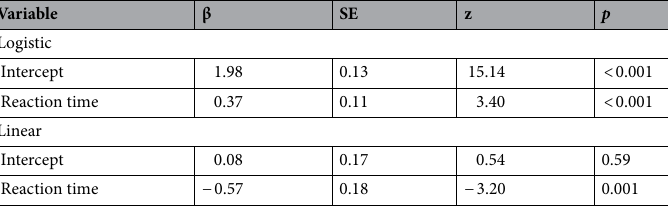
Table 1. Asssociation between confidence and reaction time based on Two-Part Multilevel Models. Statistical outcomes for the two-part multilevel models are reported separately for linear and logistic portions of the